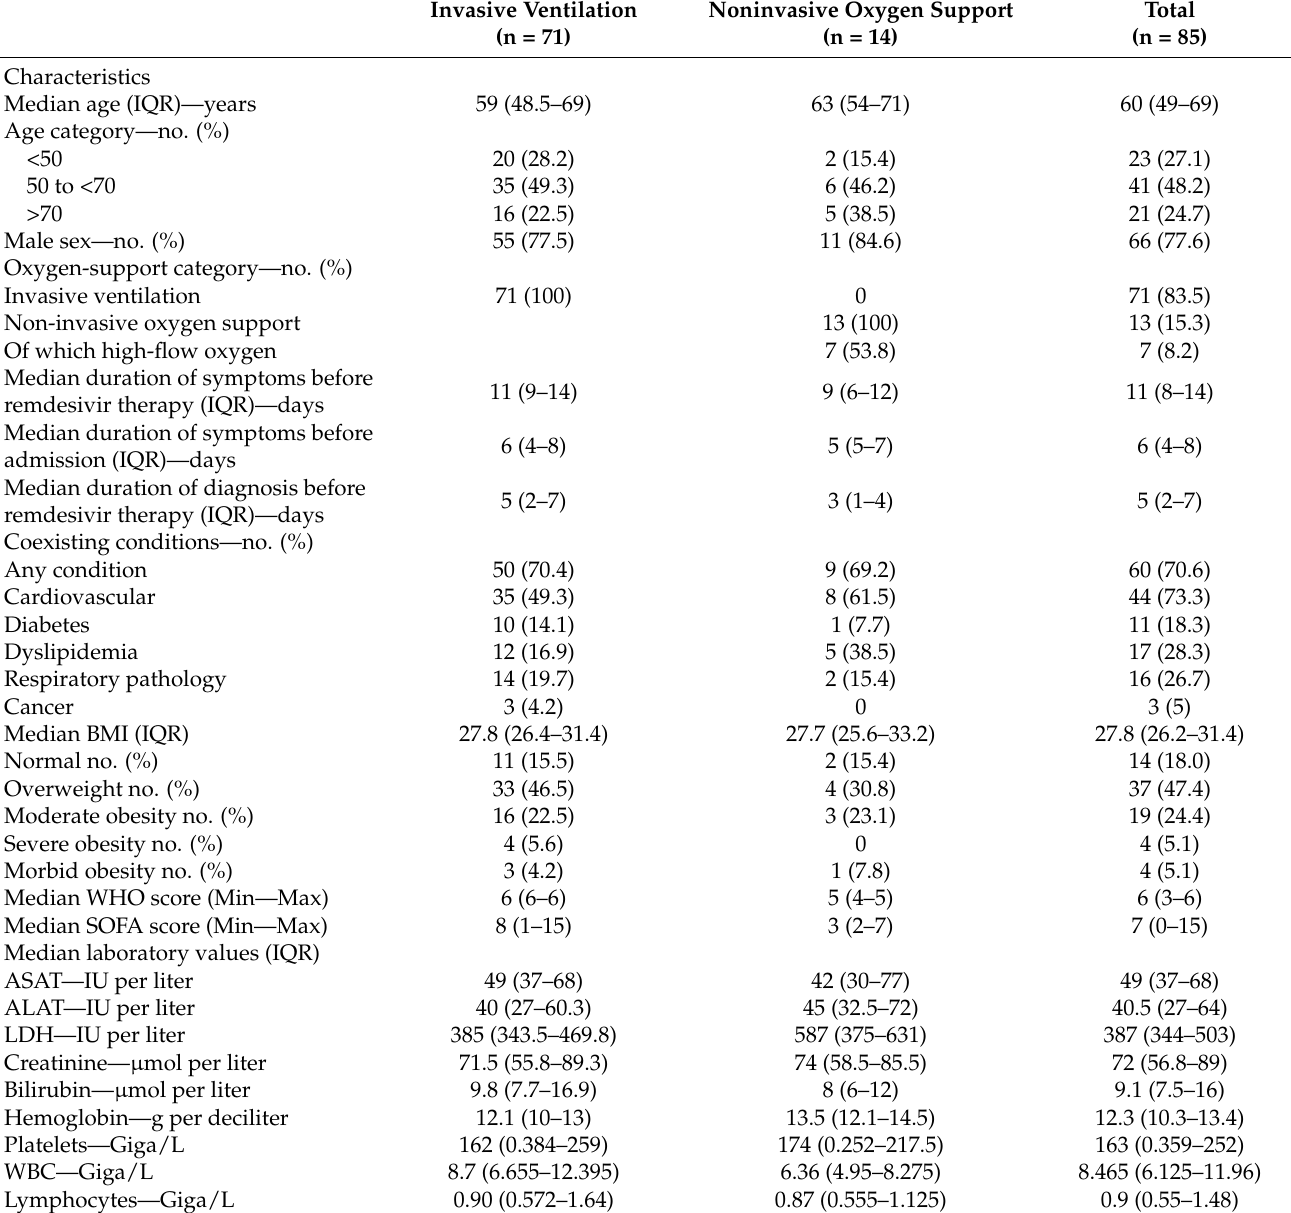
Table 1. Baseline Demographic and Clinical Characteristics of the Patients.